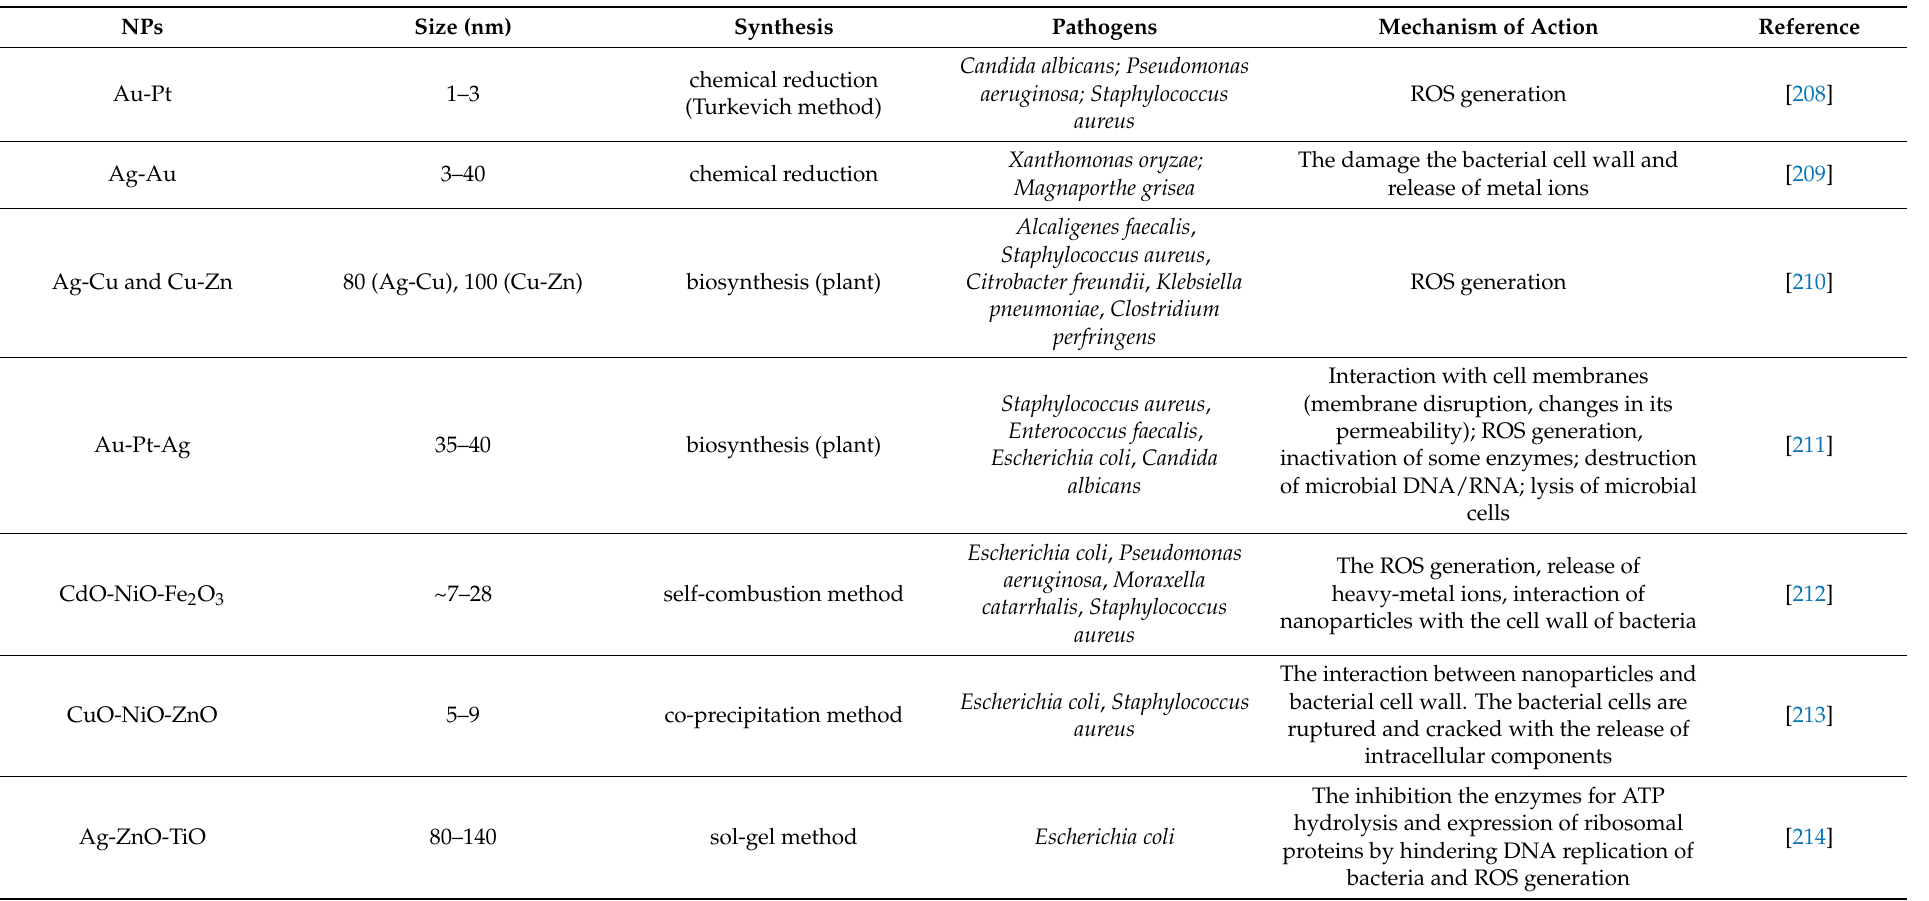
Table 3. Antimicrobial activity of multimetallic NPs. Abbreviations: Pt, platinum; CdO, cadmium (II) oxide; NiO, nickel(II) oxide; Fe 2 O 3 , iron(III) oxide; CuO, copper(II)